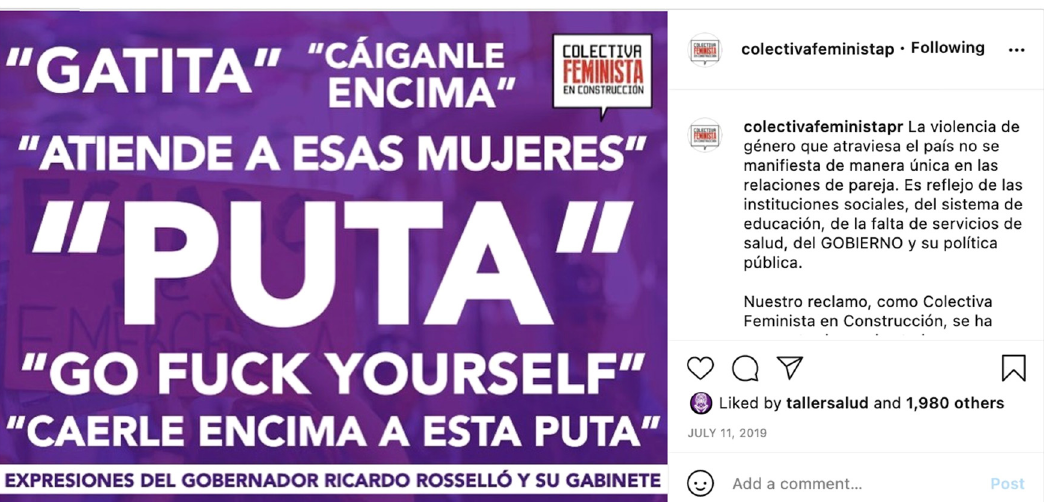
Figure 6: Screenshot from Colectiva Feminista en Construcción Instagram